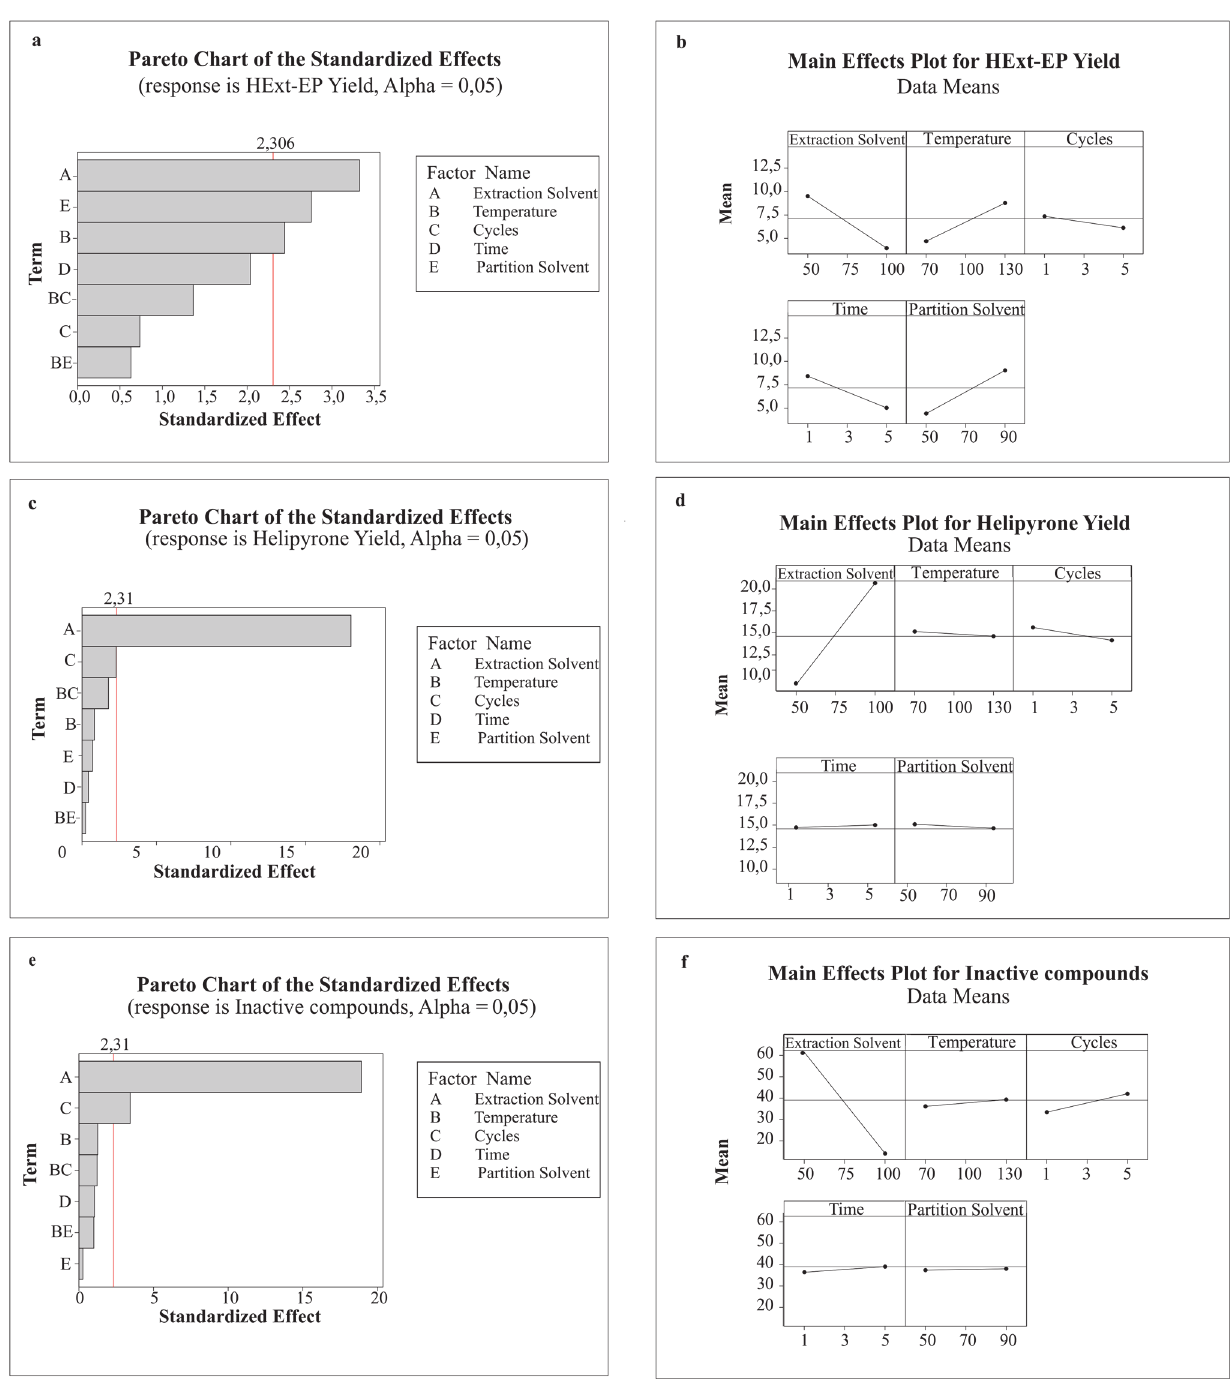
Fig 2. Pareto Chart of the standardized effects and main effects plot for HExt-EP yield (A and B), helipyrone yield (C and D) and inactive compound yield (E and F).